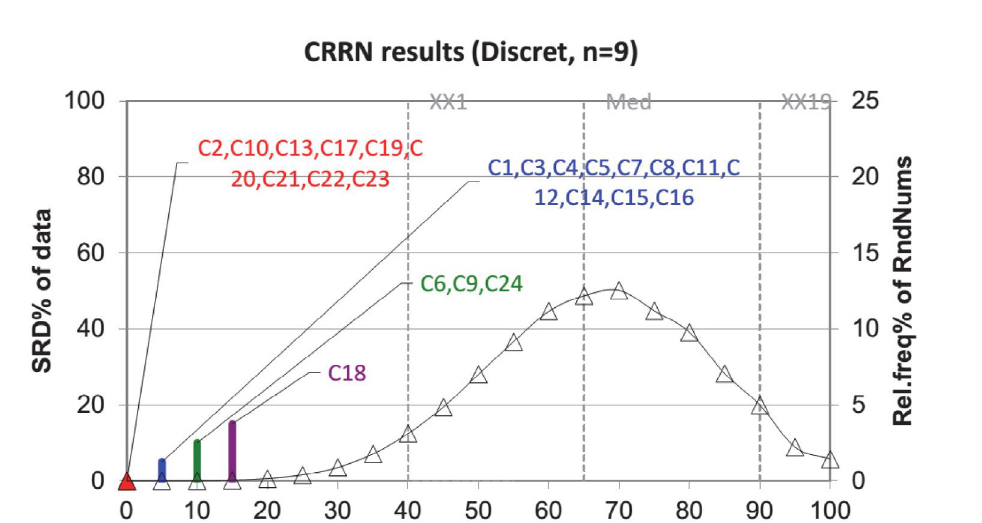
Figure 8. The result of SRD-CRRN analysis of oxazolo[4,5- b ]pyridines and benzoxazoles. The statistical properties of theoretical distribution func- tion are: first icosaile (5%), XX1 = 16; first quartile, Q1 = 22; median, Med = 26; last quartile, Q3 = 32; last icosaile (95%), XX19 = 36. neural networks which can be used in prediction of anti- fungal potential of structurally similar oxazolo[4,5- b ]pyri- dines and benzoxazoles. The prediction ability of the ob- tained networks has been confirmed by adequate